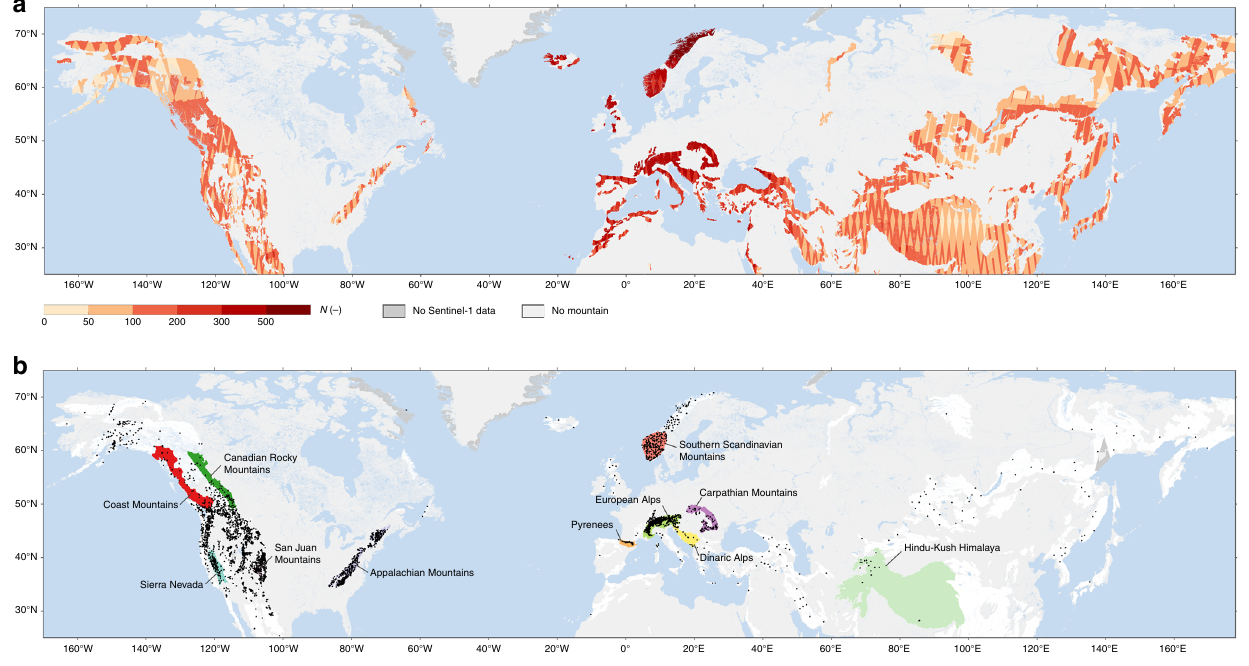
Fig. 1 Study domain and data. a The study domain corresponds to the Northern Hemisphere mountains, north of 20°N. Colors indicate the number ( N ; dimensionless) of Sentinel-1 backscatter measurements for the period September 2016 through August 2018. N is calculated after combining the ascending and descending Sentinel-1A and Sentinel-1B measurements at the daily timescale, and is limited to mountain areas observed by Sentinel-1 in vv-polarization and vh-polarization. Measurements are on average available every ~2 days in Europe and every ~4 days to ~2 weeks in North America and Asia. b In situ snow depth measurement sites within the study domain. The sources of the in situ snow depth measurements are given in Table 1. The majority of the 4175 sites is located in the western US and Europe. Measurements in Asia are more scarce. Colors highlight 11 focus mountain ranges, which were selected based on the availability of in situ measurements and based on differences in geographic location, climate, distance to the coast, elevation, and ruggedness,